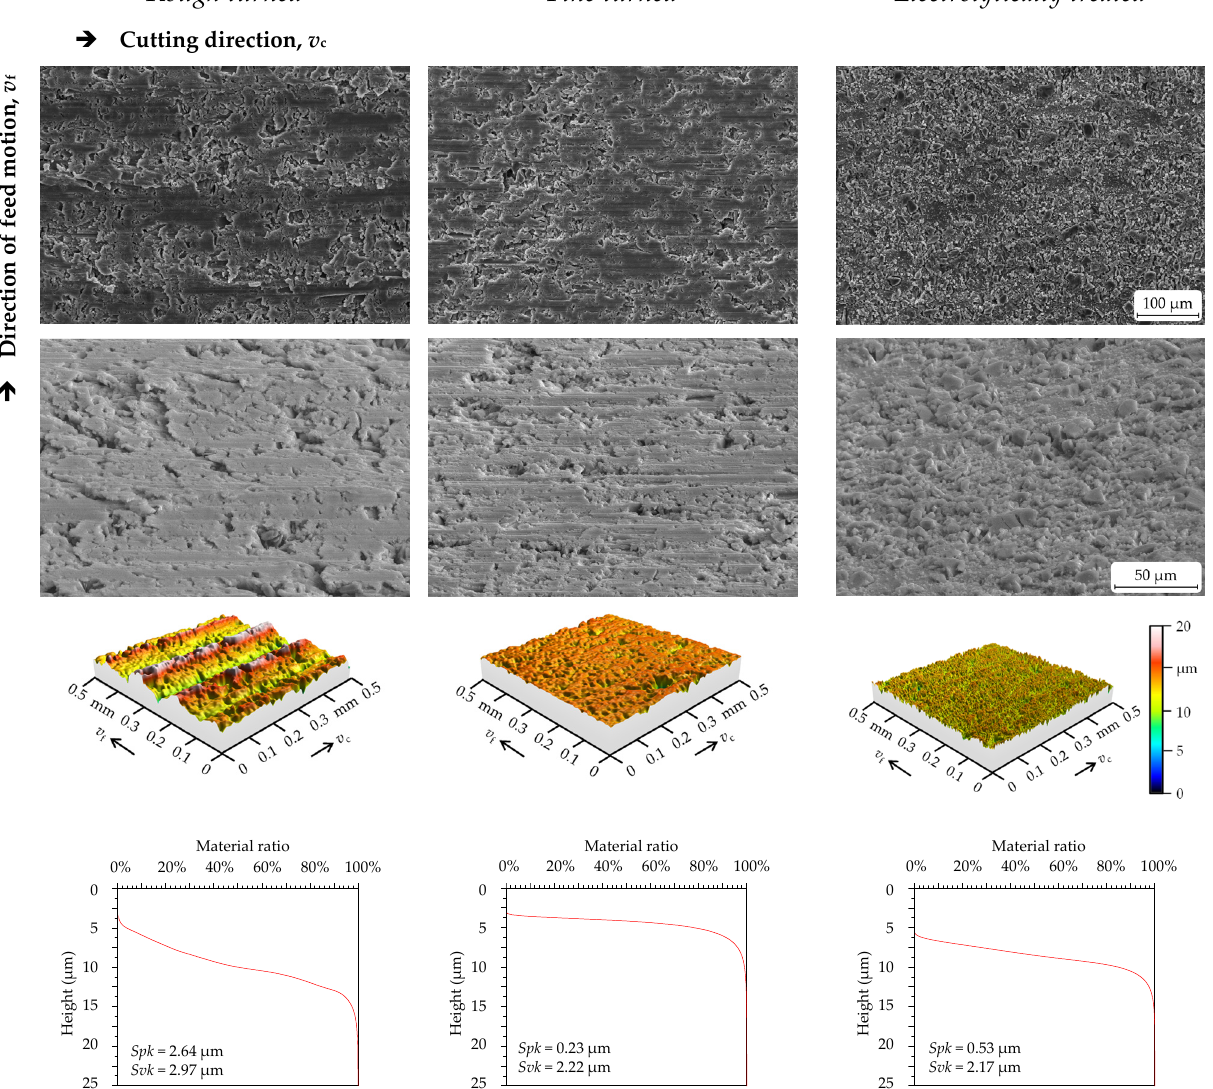
Figure 2. Secondary electron images taken by scanning electron microscopy (upper one taken vertically, and for bottom one, samples titled at an angle of 60° and higher magnification) show the surface topography of each surface condition. Below this, images of the 3D surface measurement (superelevated representation) and typical material ratio curves (MRCs, bottom) are shown.